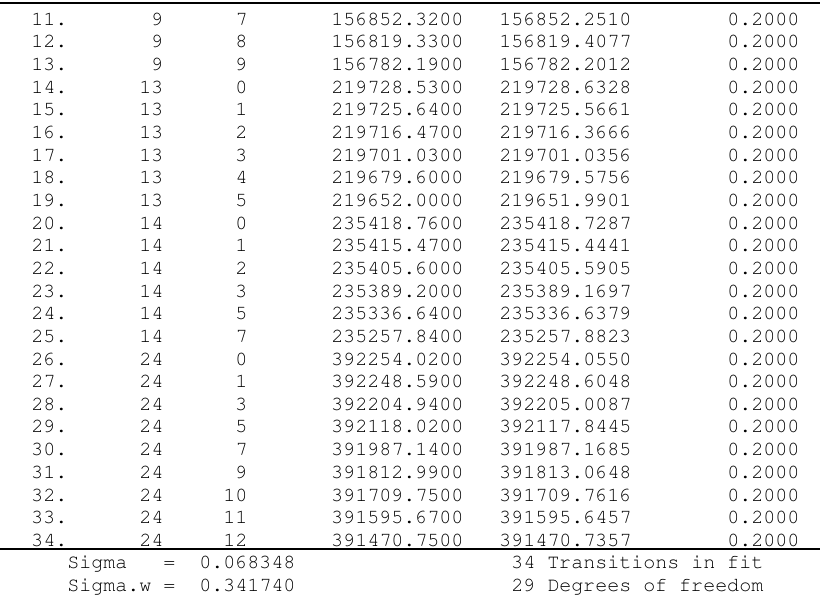
Table 14 . Results of refinement of observed frequencies for CD